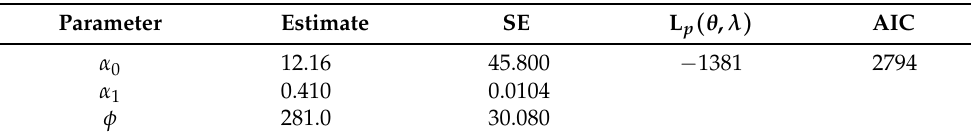
Figure 11. QQ plot for standardized residuals ( a ) and plot of index values versus standardized residuals ( b ) for the indicated model. Table 5. Maximum penalized likelihood estimates with corresponding estimated SE and AIC values under Student-t ( ν = 4) model.